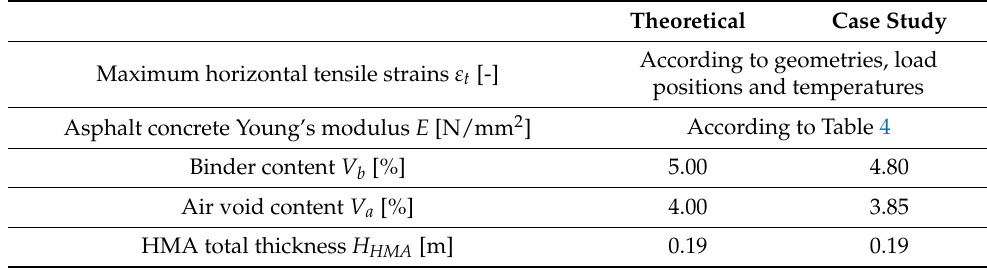
Table 5. Data for bottom-up cracking model.